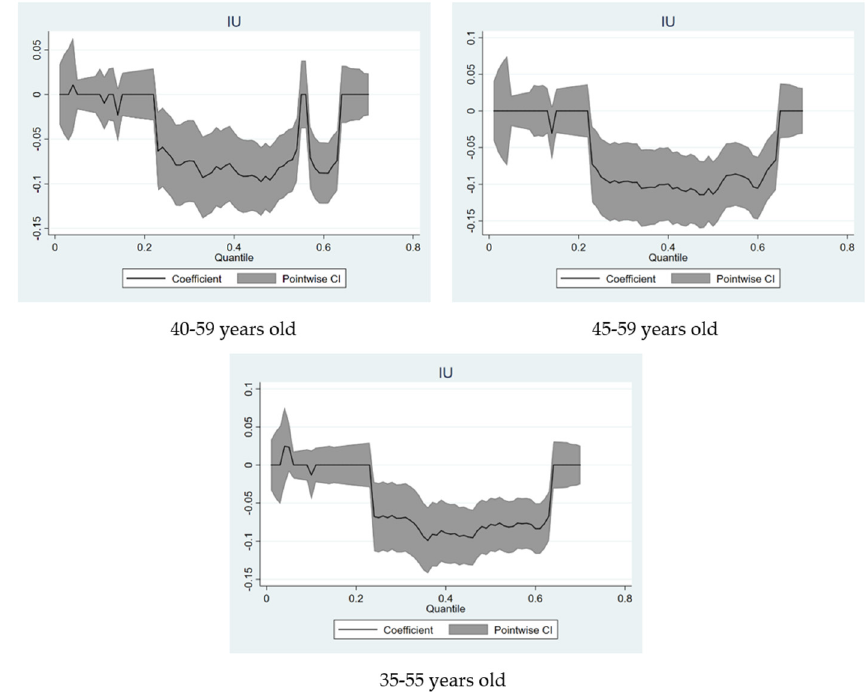
Figure 2. Quantile regression coefficients of IU under different age samples. Table 5. Analysis of the role path of social